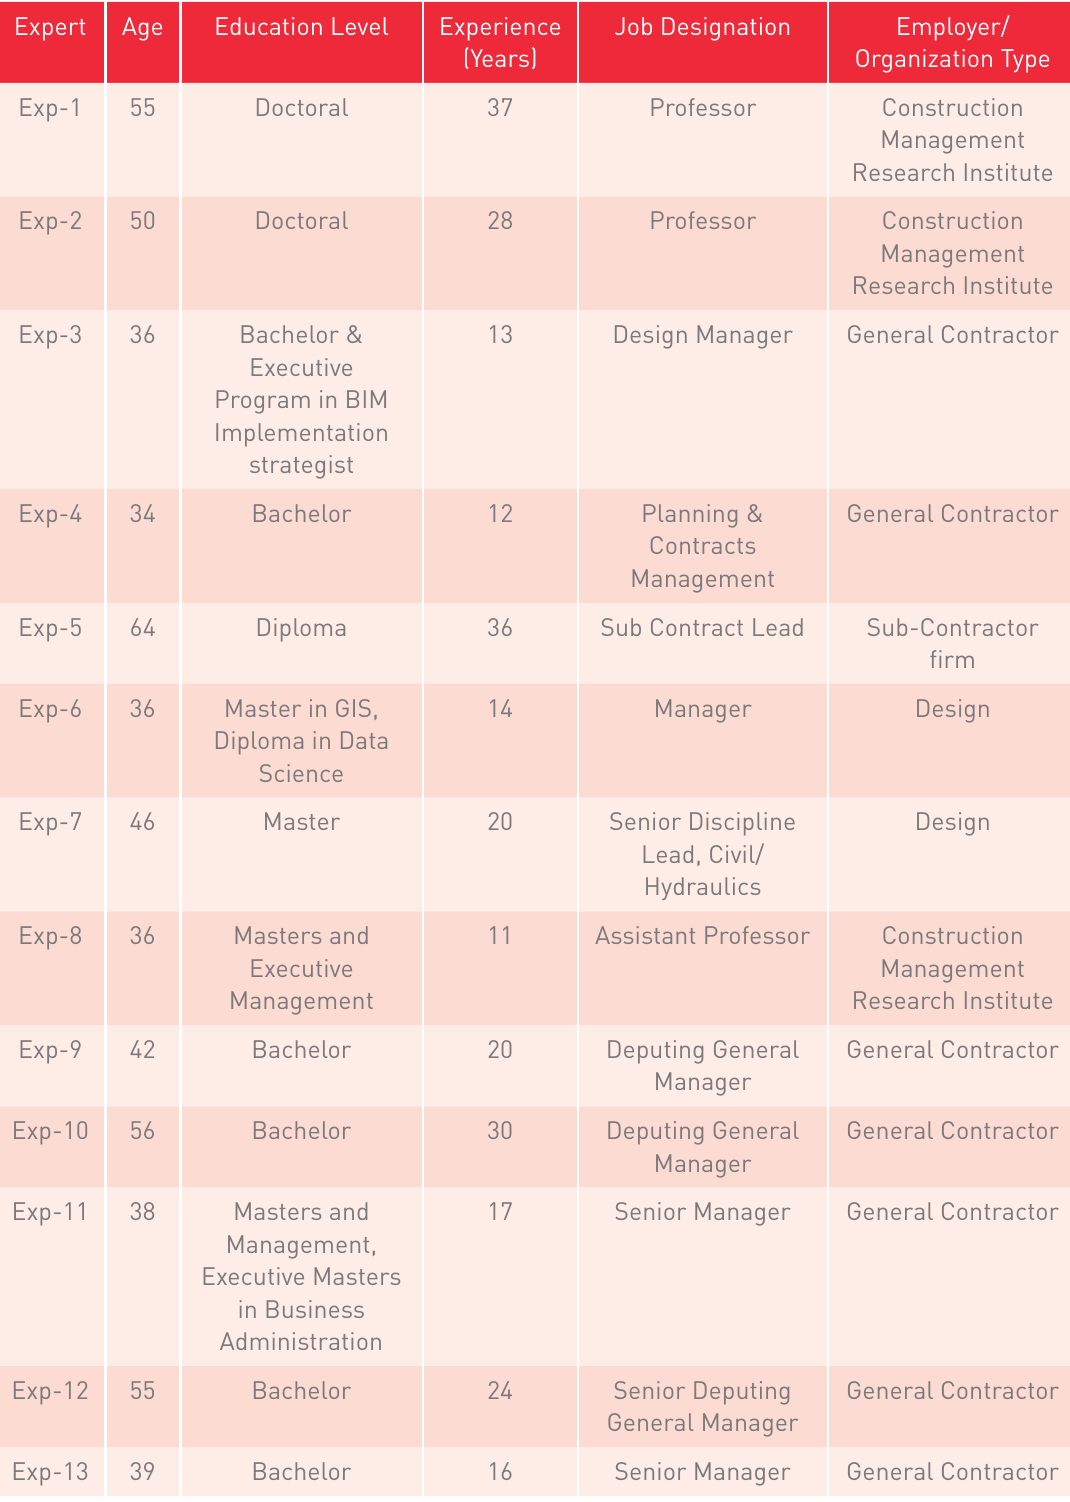
Table 4. Expert characteristics for rating interdependencies among IM